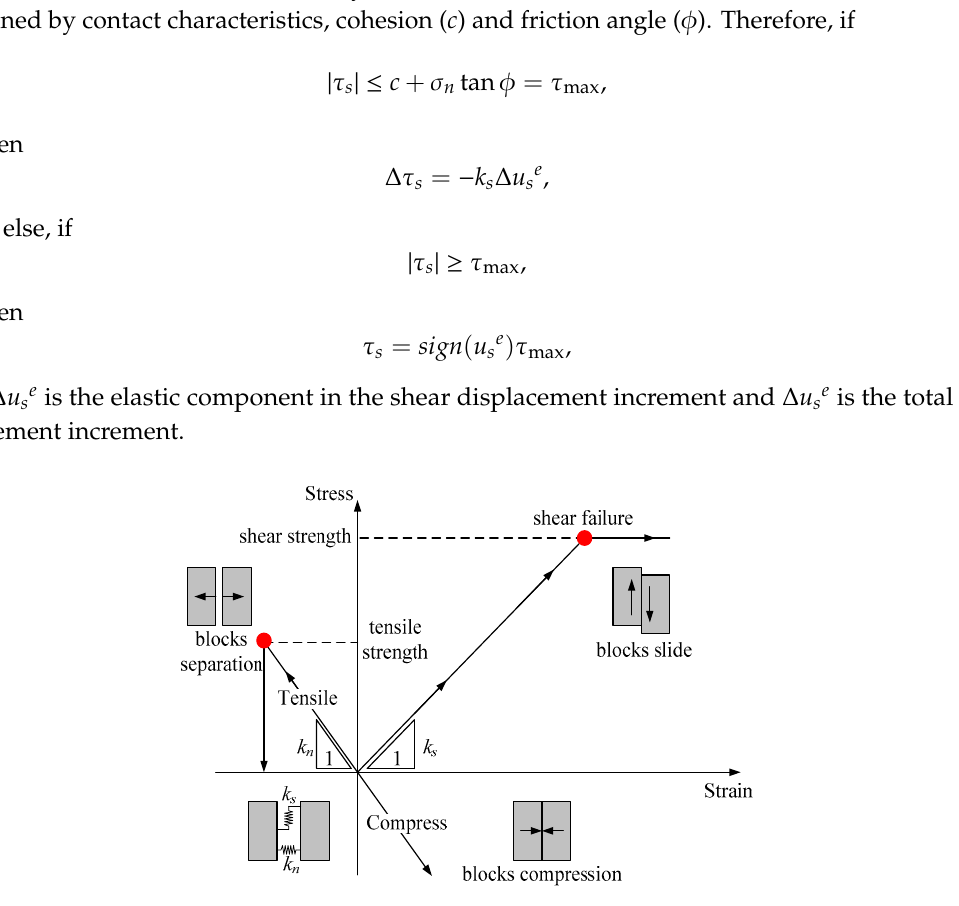
Figure 6. Mohr–Coulomb failure criterion for block in UDEC [60].